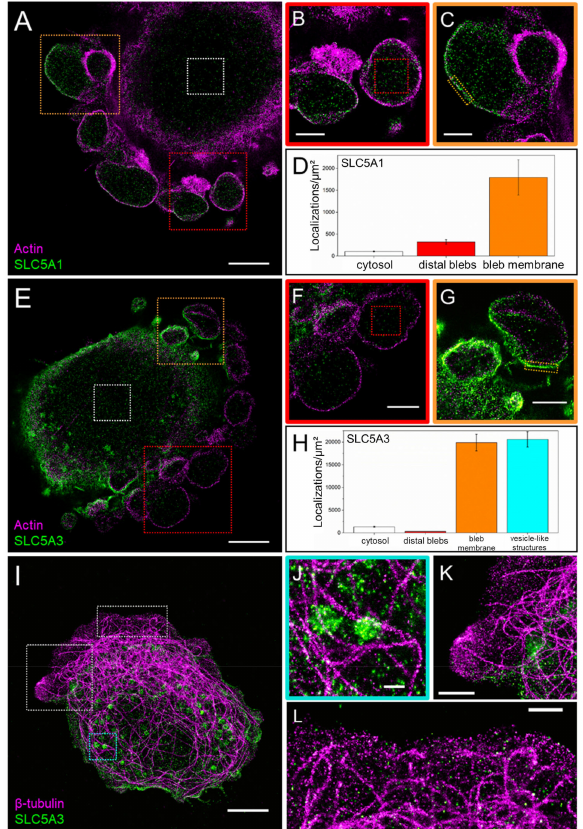
Figure 6. Two-color d STORM analyses of SLC5A1 and SLC5A3 in DK-MG cells. ( A ) Representative d STORM image of a DK-MG cell co-stained for SLC5A1 and F-actin. ( B , C ) Magnifications of the boxed regions in ( A ), depicting blebs with ( B ) or lacking ( C ) an actin cortex. ( D ) SLC5A1-localizations per µ m 2 in different cell compartments corresponding to the boxed regions in ( A ). The highest localization densities were found in the membrane of blebs most distant from the main cell body. ( E ) Representative d STORM image of a DK-MG cell co-stained for SLC5A3 and F-actin. ( F , G ) Mag- nifications of the boxed regions in ( E ), depicting distal blebs lacking SLC5A3 signal ( F ) and blebs in various life cycle stages ( G ). ( H ) SLC5A3-localizations per µ m 2 in different cell compartments corresponding to the boxed regions in ( E ). The highest localization densities were found in the membrane of blebs closest to the main cell body ( F ), as well as in vesicle-like structures close to the cell periphery ( J ). ( I ) Representative d STORM image of a DK-MG cell co-stained for SLC5A3 and β -tubulin. ( J ) Vesicle-like SLC5A3 structures localized in close vicinity to microtubules. ( K , L ) Micro- tubules extending into the outermost leading edge, virtually devoid of SLC5A3. Scale bars: 5 µ m in ( A , E , I ); 2 µ m in ( B , C , F , G ), 1 µ m in ( K , L ); 500 nm in ( J